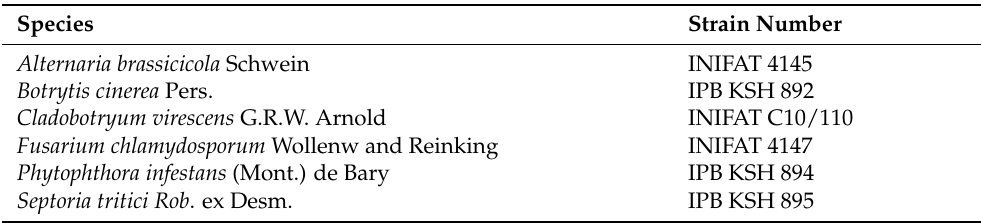
Table 1. Registration number of strains used in this research and preserved at INIFAT and IPB culture